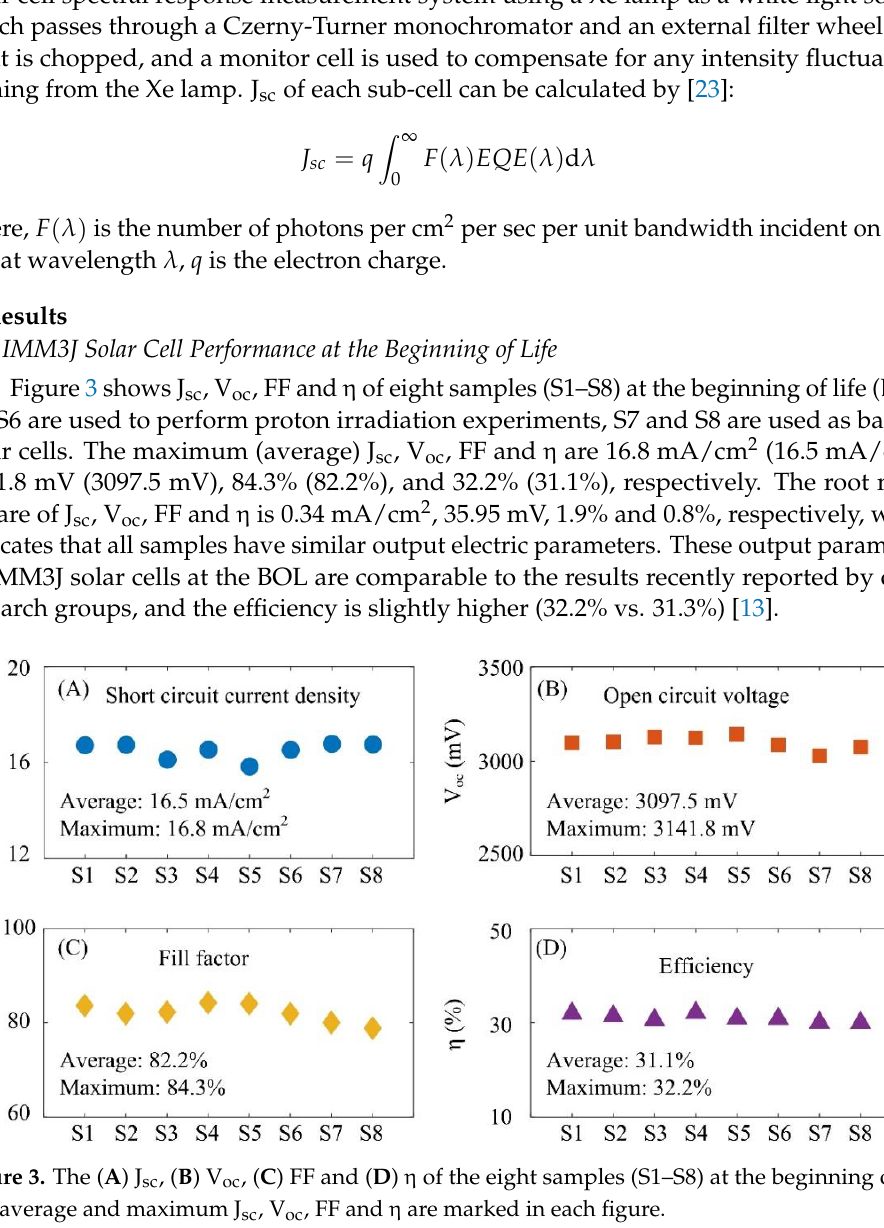
Figure 2. Photograph of the proton irradiation experiment. Six solar cells (No. 1–6) are used for the